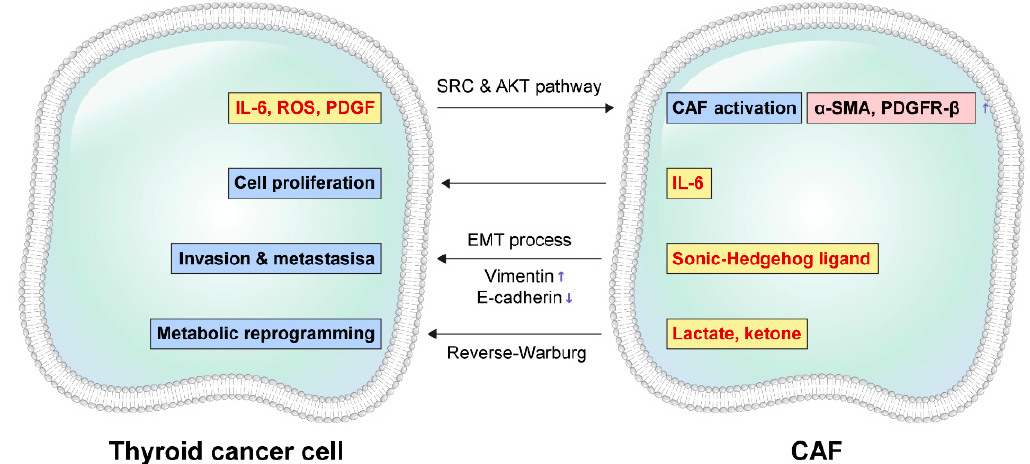
Figure 2. Interaction between cancer cells and caner-associated fibroblasts (CAF) in thyroid cancer. The expressions of CAF markers, α -SMA and PDGFR- β , are increased by SRC and AKT pathway activated by IL-6, ROS, PDGF that are secreted by thyroid cancer cells. SRC and AKT pathway differentiates and activates CAF. IL-6 secreted by CAF promotes tumor cell proliferation, and Sonic-Hedgehog ligand secreted by CAF promotes cancer cell invasion and metastasis through EMT process. In this EMT process, the expression of vimentin is increased and the expression of E-cadherin is attenuated. Moreover, lactate and ketone produced by glycolysis in CAF are transported to tumor cells and used in energy production by TCA cycle. This metabolic reprogramming is called the reverse-Warburg effect.